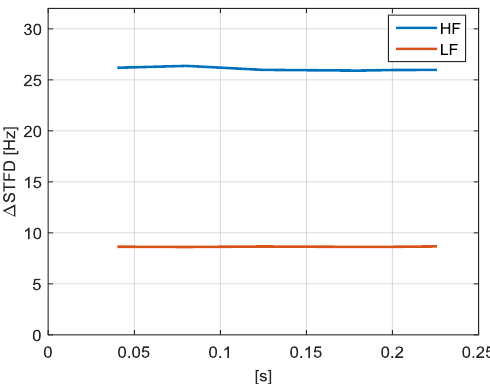
Figure 28. Case study 1: STDE at low-frequency (0 ÷ 2 kHz, red line) and at high-frequency (2 ÷ 150 kHz, blue line) obtained through Prony’s method.